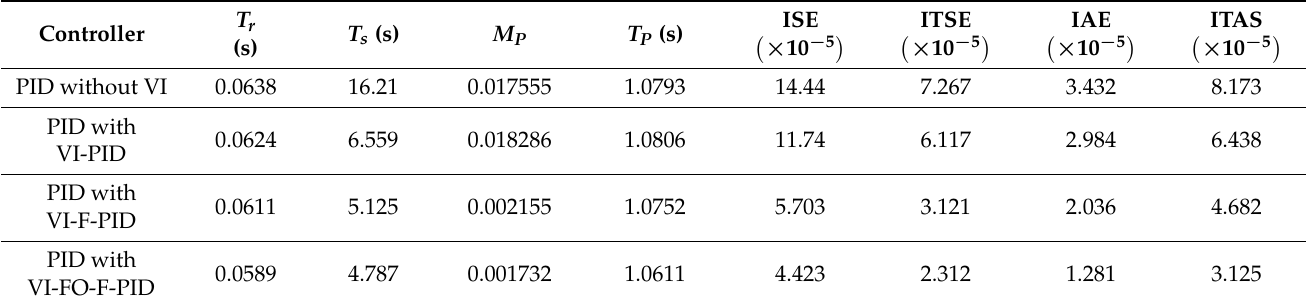
Table 3. Comparative study of dynamic responses offered by the HPSREG under step load perturbation. Controller